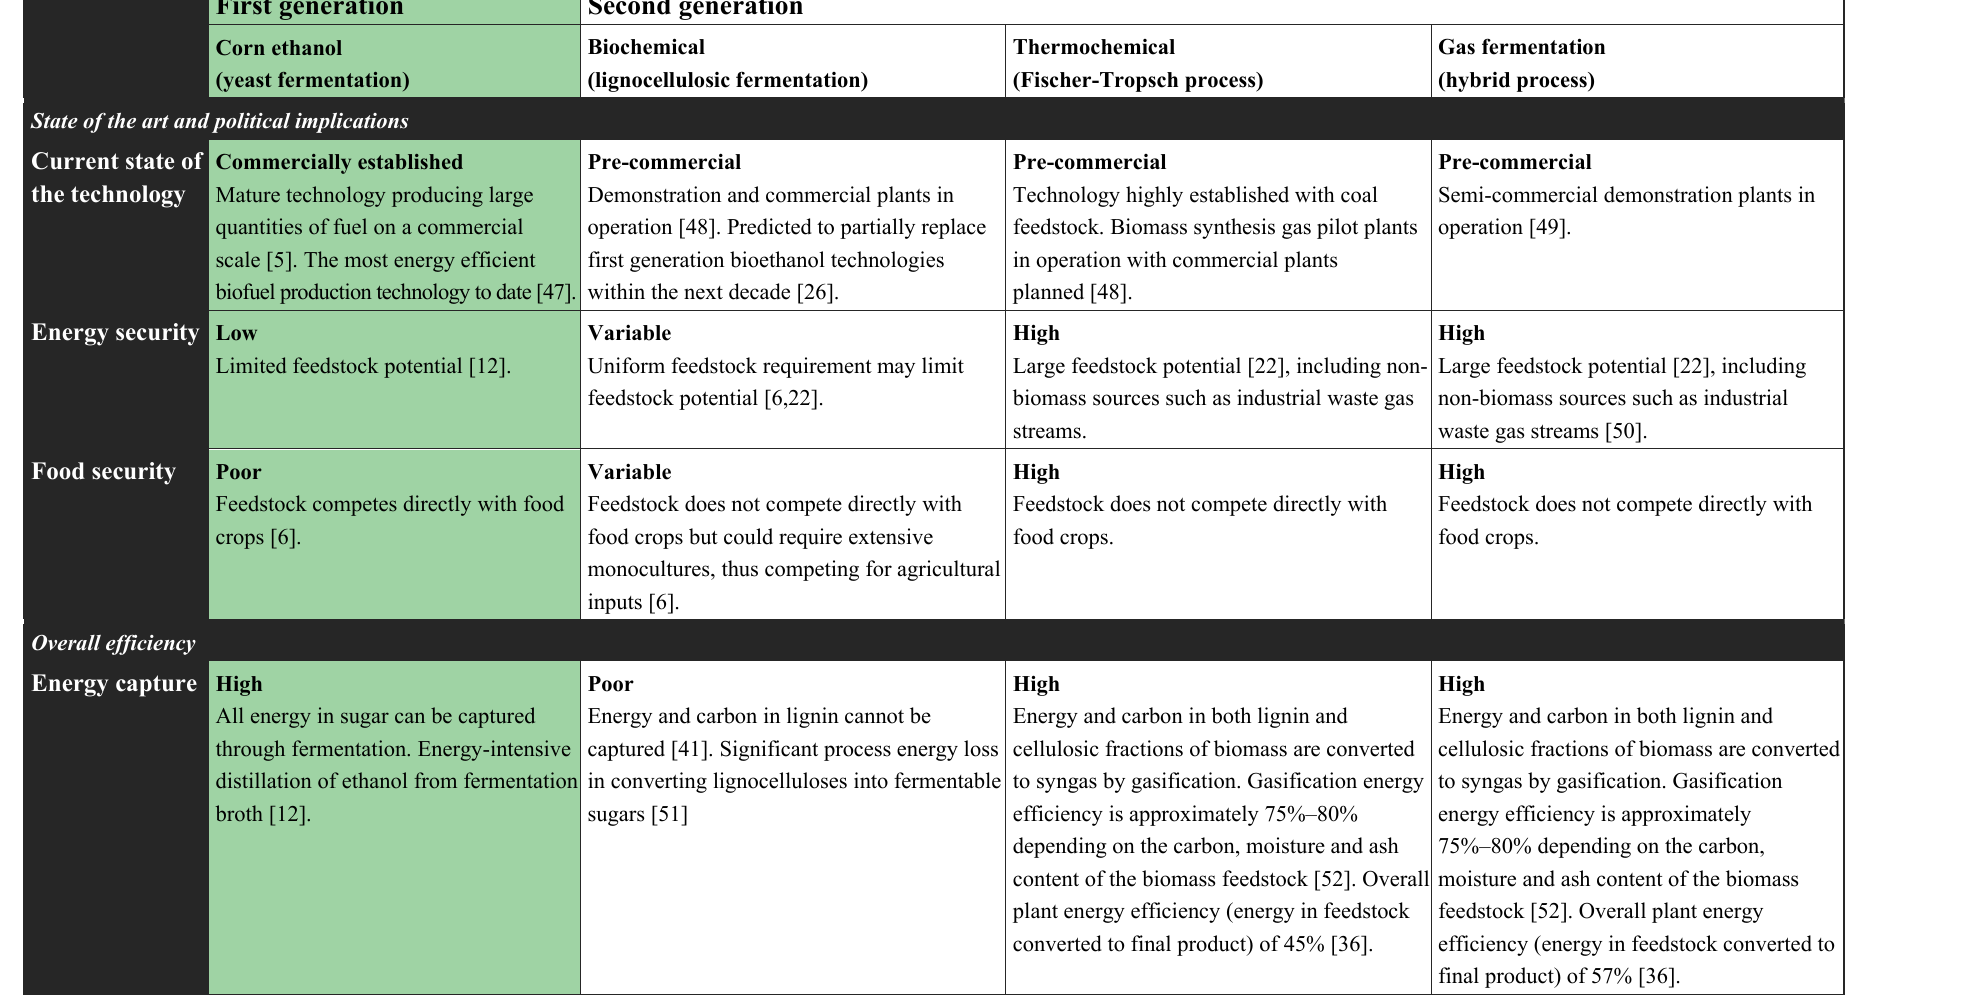
Table 1. Comparison between first generation, and second generation biochemical, thermochemical and gas fermentation biomass-to-biofuel